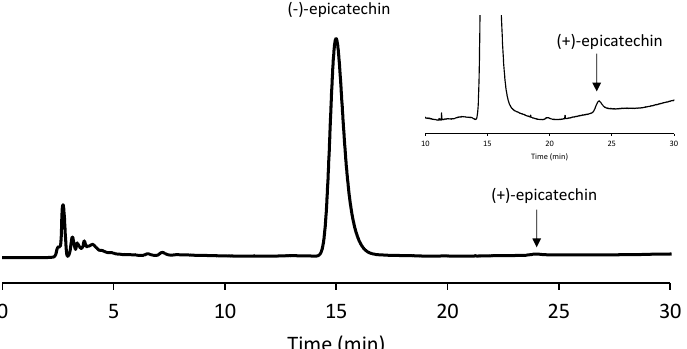
Figure 2. Representative enantioselective analysis of the peak corresponding to epicatechin in the achiral HPLC chromatogram. The magnified section of the chromatogram makes it evident the subtle presence of the (+)-epicatechin isomer.